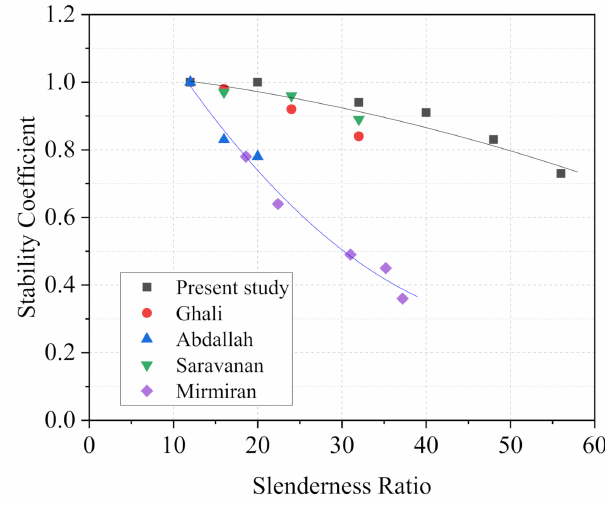
Figure 6. Effect of slenderness on the stability